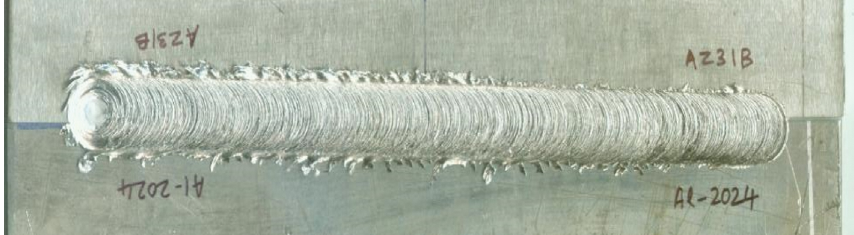
Figure 3: Surface morphology of the FSW of Al alloy to Mg alloy weld coupon, obtained by interface offset varying weld- ing with optimized parameters: rotational speed = 300 rev min − 1 , welding speed = 50 mm min − 1